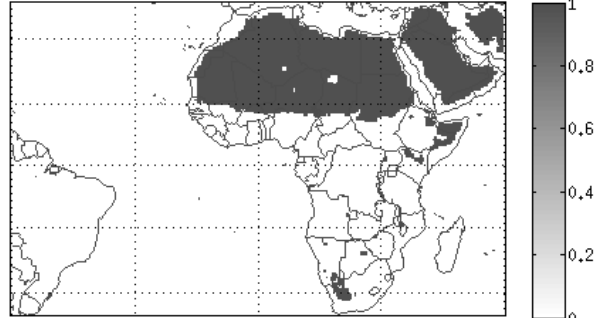
Figure 1. Map of arid land identified using the annual mean of the 19GHz channels difference (V–H). Dark grey areas are the regions identified as desert or arid